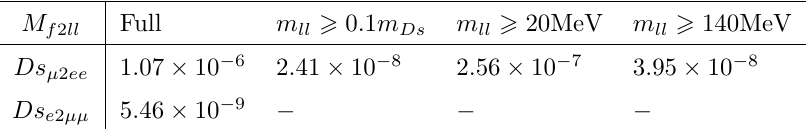
Table 2 . In the SM framework, similar cuts in the di-lepton mass for the BR( Ds j 2 ii ), used in the decay width calculations for IB+SD